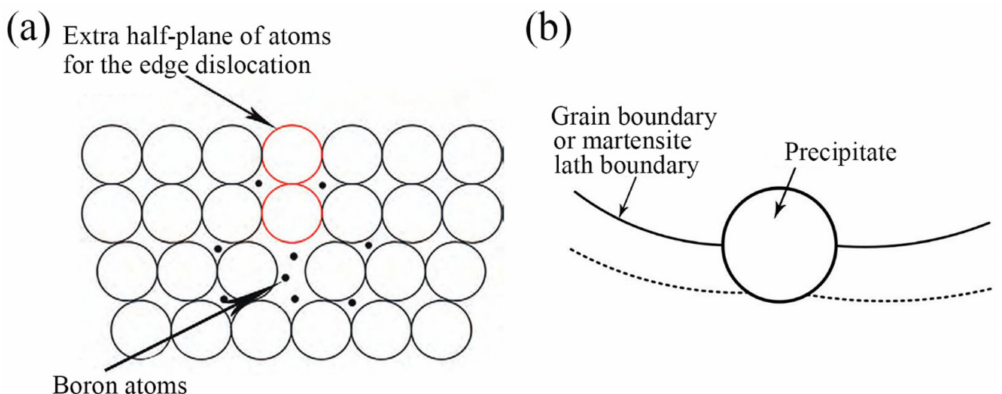
Figure 12. ( a ) Boron distribution in FB2 matrix under slow heating condition [80] and ( b ) the pinning e ff ect of precipitate on grain boundary or martensite lath boundary